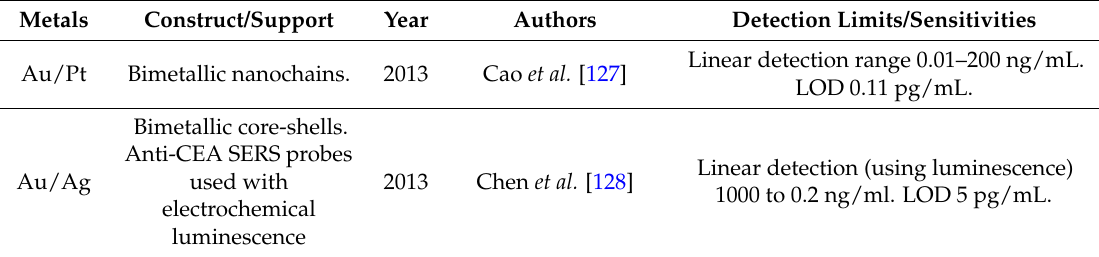
Table 6. Metals and constructs used for sensors designed for carcinoembryonic antigen (CEA)